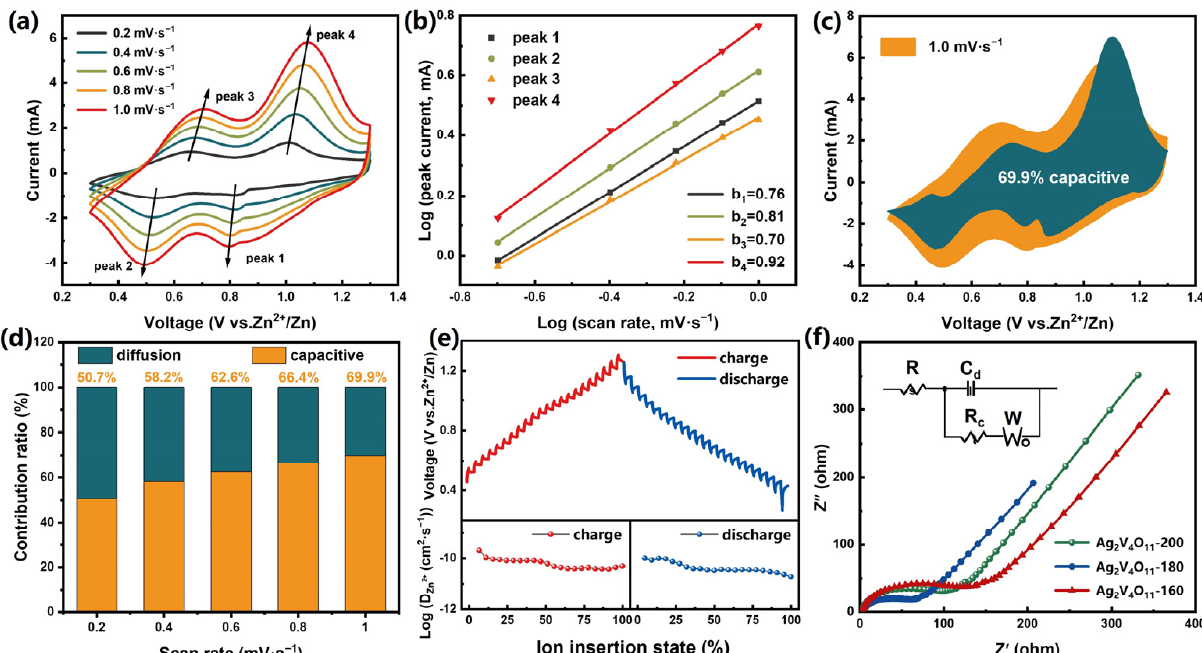
Figure 4. CV curves at various scan rate from 0.2 mV · s − 1 to 1.0 mV · s − 1 ( a ); log( i )-log( v ) plots at specific peak currents ( b ); Capacitive contribution at 1.0 mV · s − 1 ( c ); the pseudocapacitive contribution (orange region) at various scan rate from 0.2 mV · s − 1 to 1.0 mV · s − 1 ( d ); GITT curves and diffusion coefficient for Zn 2+ in the second charge-discharge process ( e ); Nyquist plots of Zn//Ag 2 V 4 O 11 batteries ( f ). −